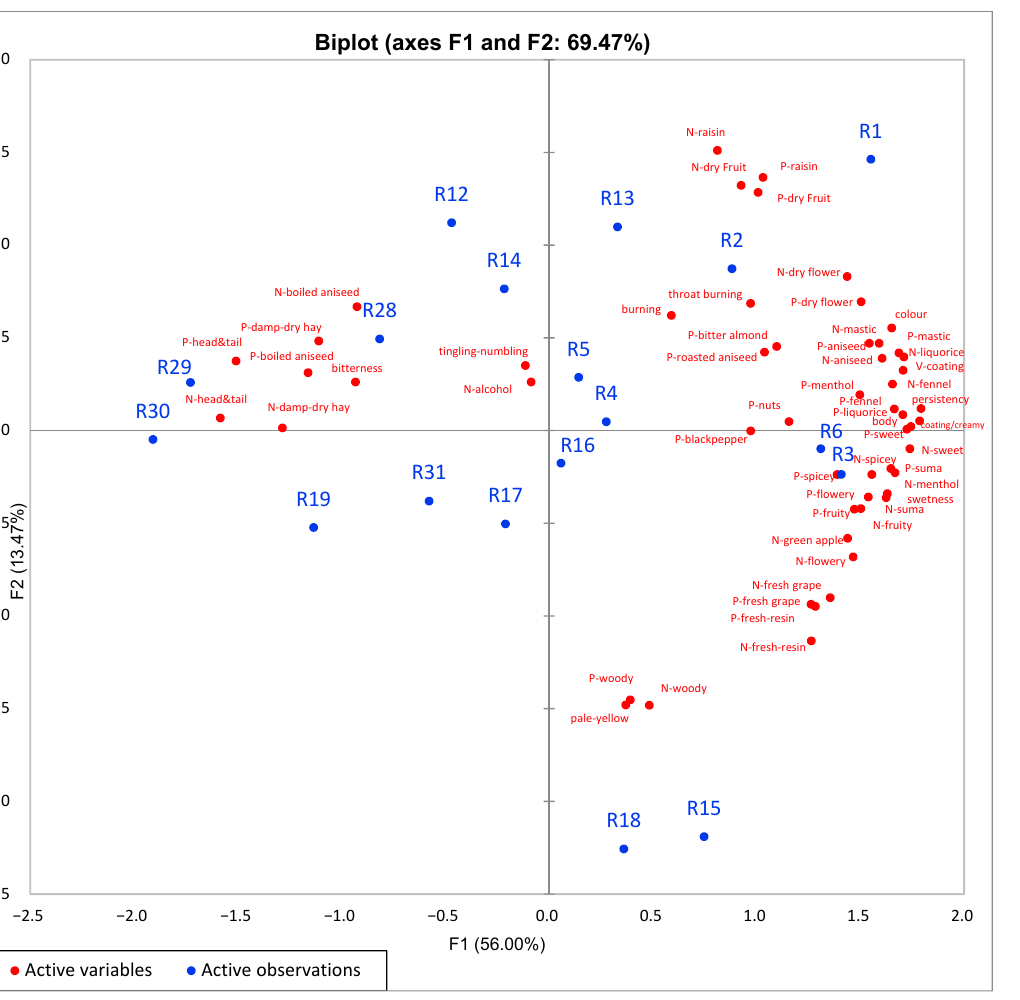
Figure 2. Principal component analysis (PCA) of the trained panel evaluation for appearance (colour and V-coating), aroma on the nose (N), aroma in the mouth (retro-nasal) (P), taste, and mouthfeel attributes of Rak ı samples. Appearance was evaluated according to white colour, visual coating and pale-yellow colour attributes in DA. Aniseed has an effect on the appearance of Rak ı . Before the prep- aration of Rak ı for consumption, it contains 40–50% alcohol by volume (ABV) and over